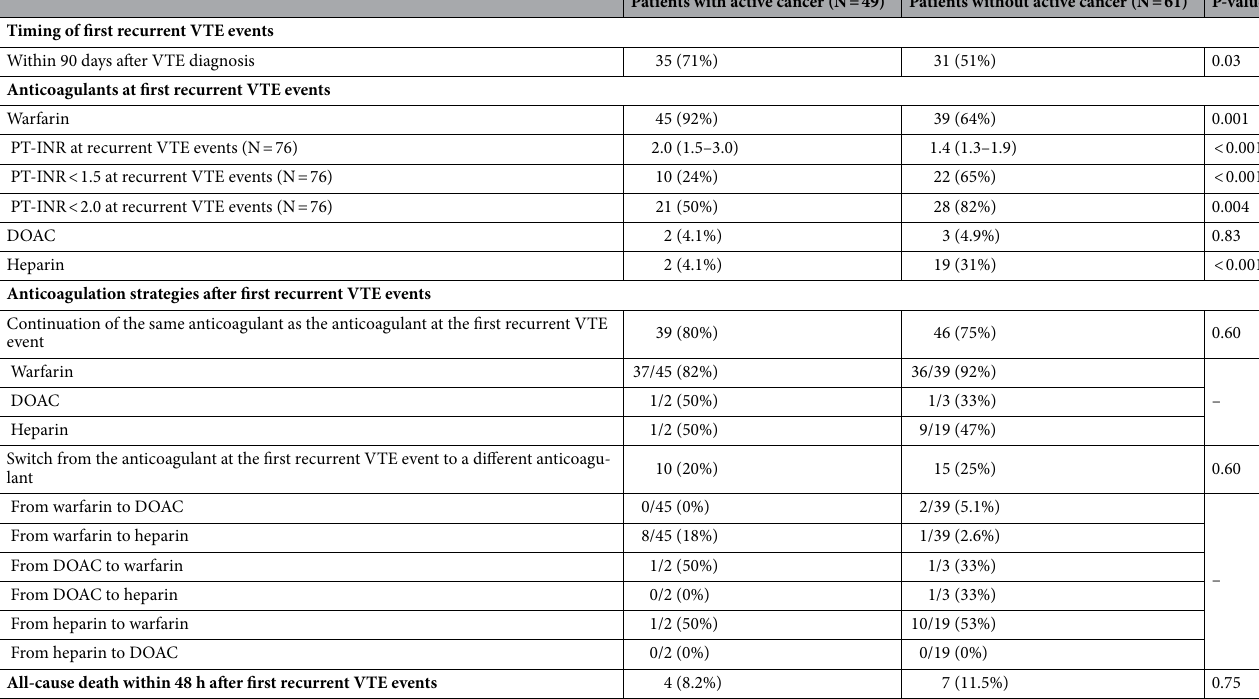
Table 3. Characteristics and management strategies of first recurrent VTE during anticoagulation therapy comparing patients with and without active cancer. Categorical variables are presented as numbers and percentages, and continuous variables are presented as the median and interquartile range. Categorical variables were compared using the chi-squared test when appropriate; otherwise, Fisher’s exact test was used. Continuous variables were compared using Wilcoxon’s rank sum test. VTE venous thromboembolism, PT-INR prothrombin time-international normalized ratio, DOAC direct oral anticoagulant.